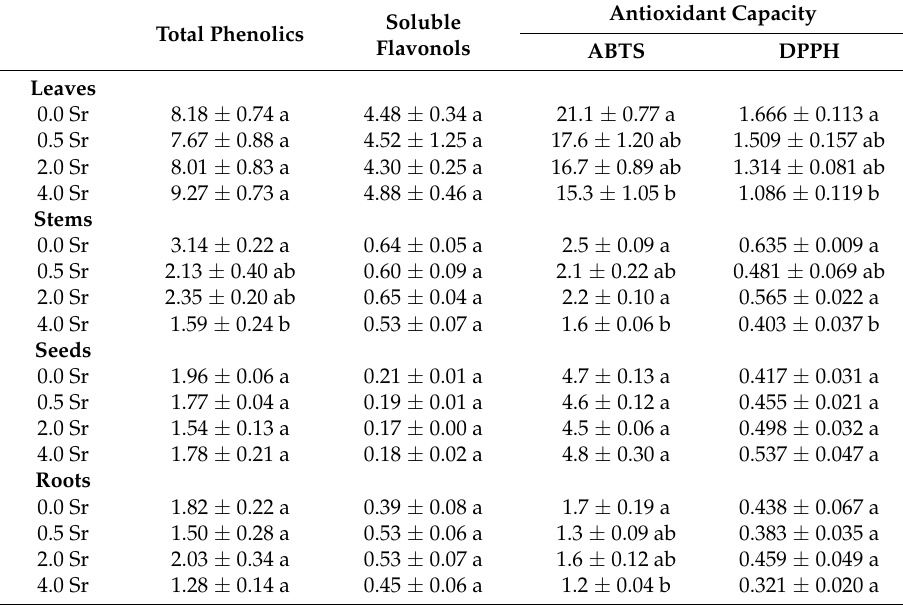
Effect of various Sr concentrations (mM) in the nutrient medium on the total phenolic content (TPC), soluble flavonolos, and antioxidant capacity determined using 2-azino-bis-3-ethylbenzthiazoline-6-sulphonic acid (ABTS) and 2,2-diphenyl-1-picrylhydrazyl (DPPH) in the Glycine max plants. Units: mg TE g − 1 ADW (for antioxidant capacity), mg g − 1 ADW (for TPC), mg g − 1 ADW (for soluble flavonols). Data are means ± SE ( n = 4). Different letters denote significant difference at the 0.05 level of Tukey’s test between the Sr treatments within the same plants